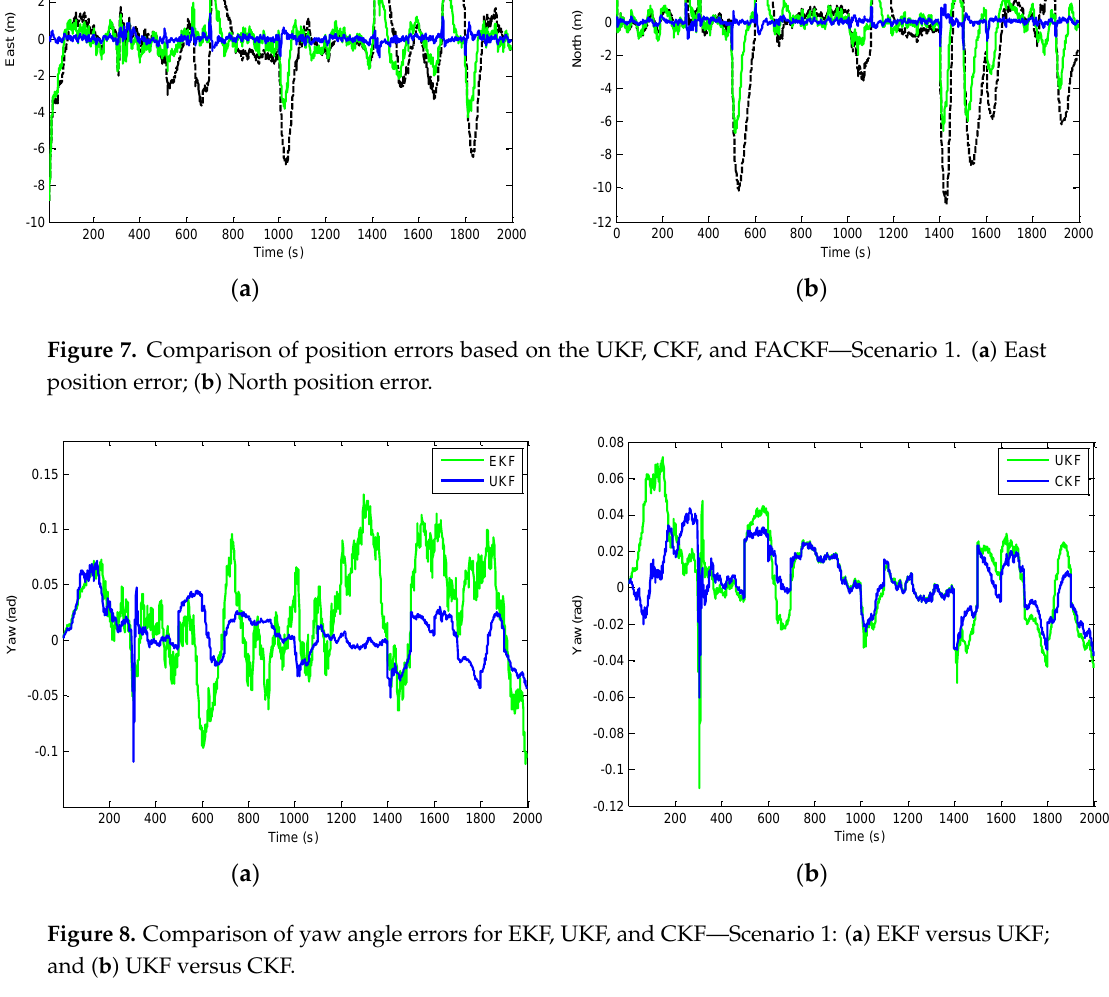
Figure 8. Comparison of yaw angle errors for EKF, UKF, and CKF—Scenario 1: ( a ) EKF versus UKF; and ( b ) UKF versus CKF.